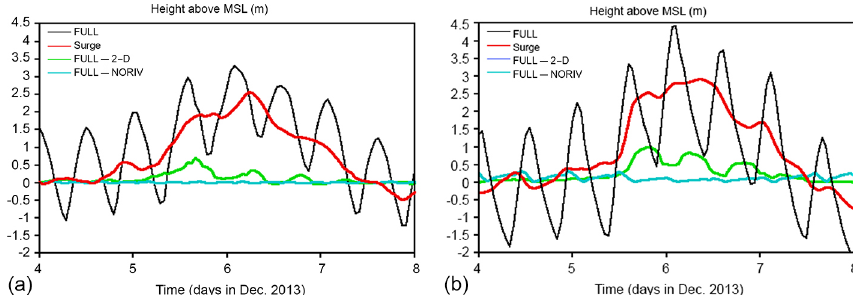
Figure 14. The role of the baroclinicity for the sea level variability in the ST3 and ST6 stations; for the FULL run (black line); storm surge (red line); differences between the FULL and 2-D runs for the storm surge (FULL–2-D, green line); differences between the FULL and NORIV runs for the storm surge (FULL–NORIV, blue